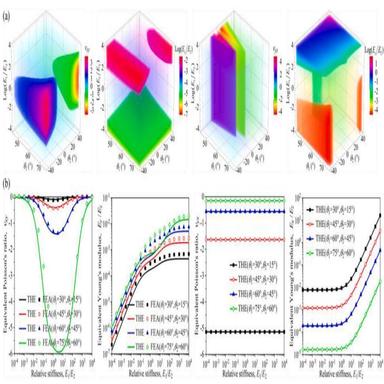
The influence of geometric parameters and constitute materials (relative stiffness) on elastic constants of composite 3D DVH lattices, (a) equivalent Poisson's ratio and relative Young's modulus of composite 3D DVH lattices as functions of θ1, θ2 and relative stiffness E1/E2 (t1/l = t2/l = b/l = 0.1) in density map, (b) equivalent Poisson's ratio and relative Young's modulus of composite 3D DVH lattices as functions of relative stiffness E1/E2 (t1/l = t2/l = b/l = 0.1).